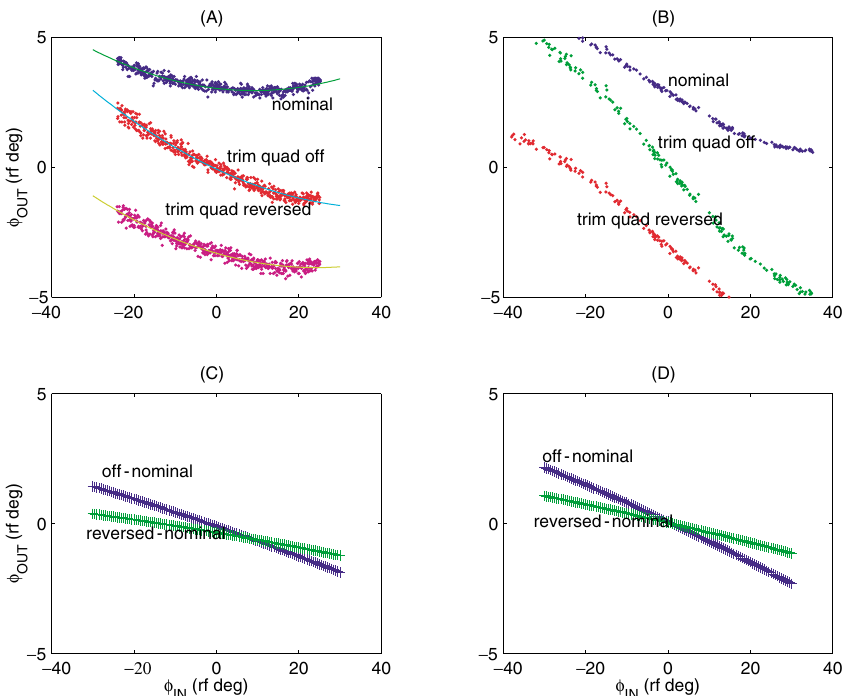
FIG. 9. (Color) Example of a difference compression efficiency transfer map measurement at the detector C2. The map is measured (a) and simulated (b) for three excitations of one pair of trim quadrupoles in the arc 1 (quadrupoles set up to their nominal values, turned off, and set up to a value opposite to their nominal value). Though the simulated and measured maps differ, the measured (c) and (d) simulated difference map results are in better agreement.